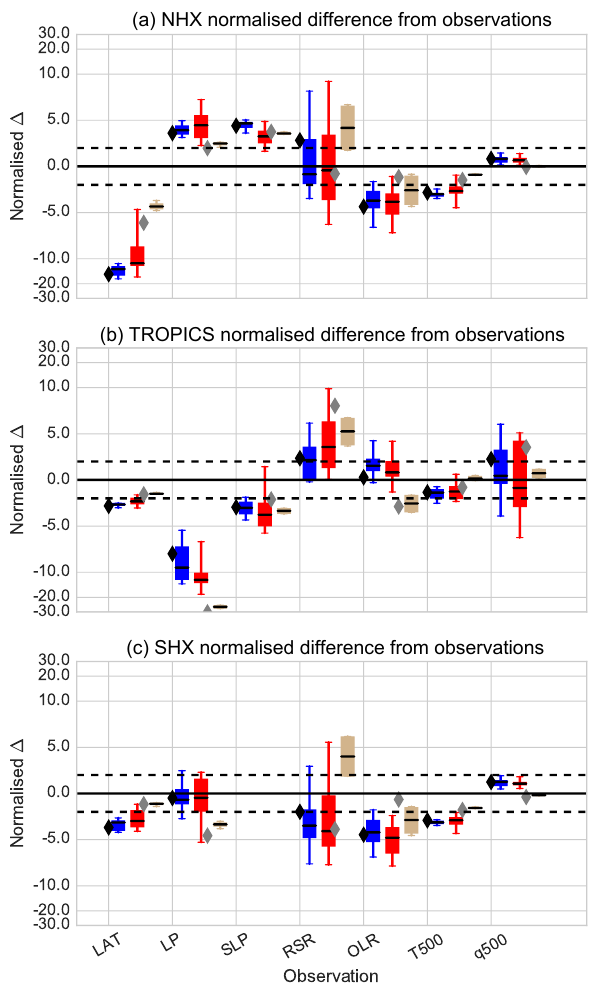
Figure 4. As in Fig. 3 except shown are initial extreme random parameter choices for 7- (red) and 14-parameter (blue)